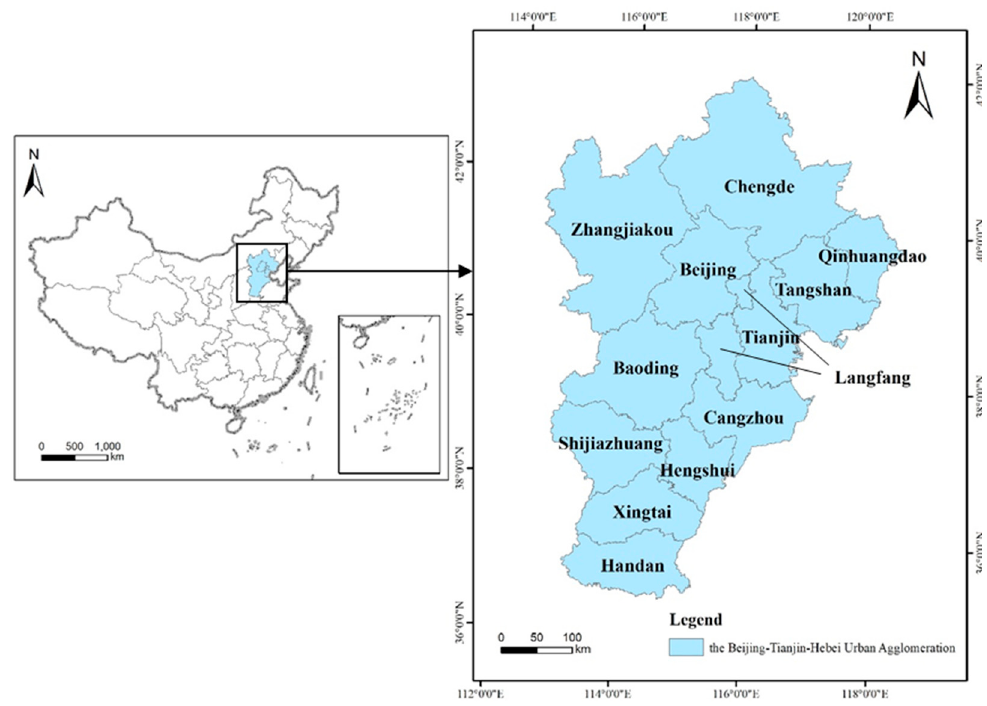
Figure 1. The location and range of the Beijing–Tianjin–Hebei urban agglomeration. Data Source: http://bzdt.ch.mnr.gov.cn/ (accessed on 23 June 2021).